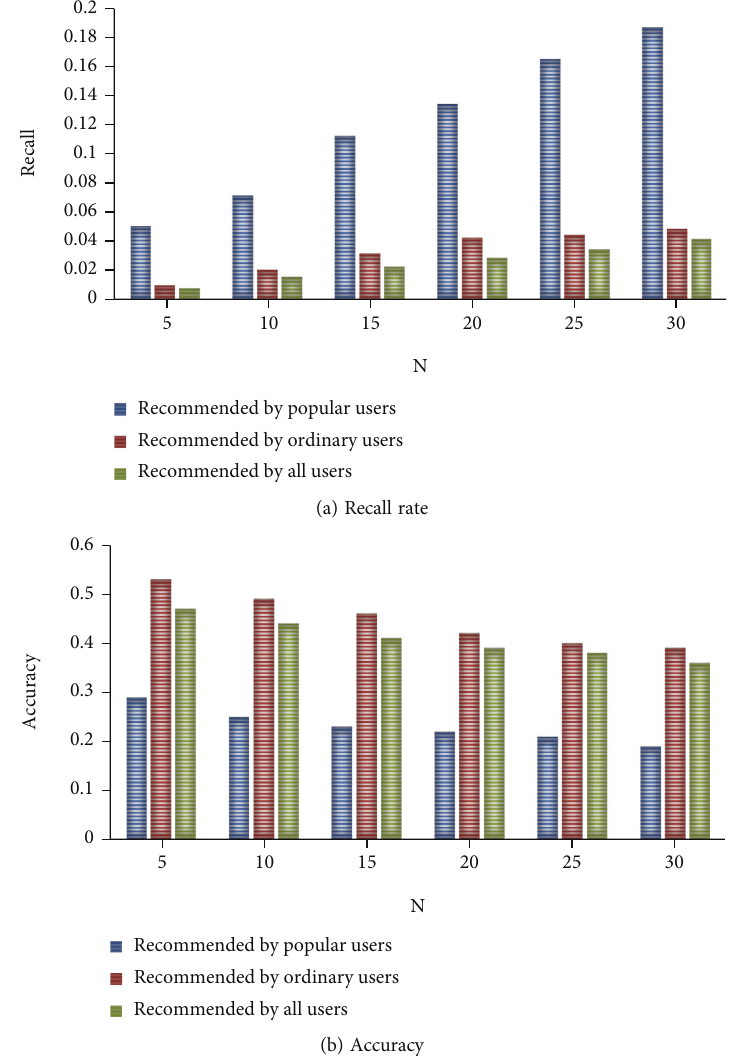
Figure 10: Comparison of sorting accuracy and